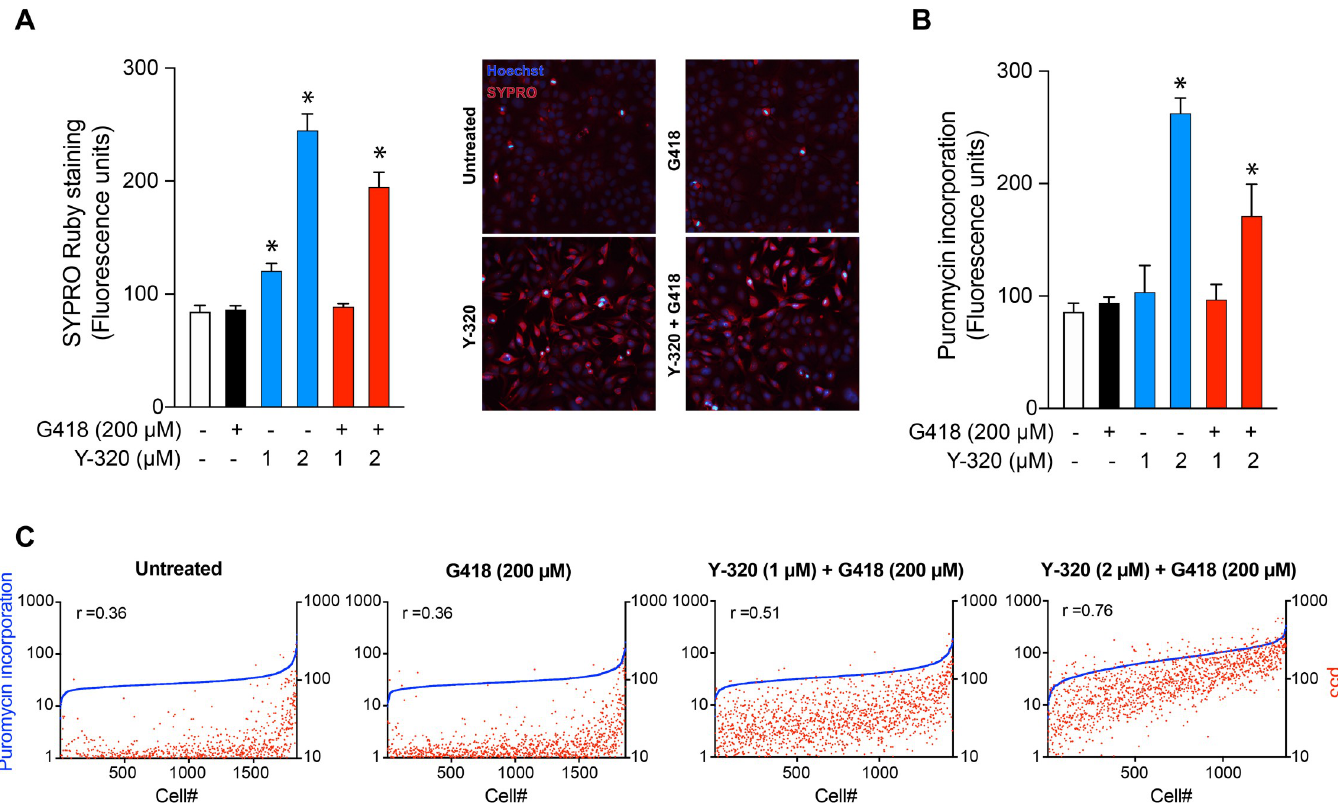
Fig 3. Stimulation of protein synthesis by Y-320 and correlation with p53 readthrough at the single cell level. (A) SYPRO Ruby protein staining. HDQ-P1 cells treated with the indicated compounds for 48 h were stained using SYPRO Ruby. Data were collected by automated fluorescence microscopy. Representative images are shown with SYPRO Ruby stain in red and nuclei in blue. (B) Puromycin detection of protein synthesis. Treated HDQ-P1 cells were exposed to puromycin and labeled with anti-puromycin AF488 antibody. Data were collected by automated fluorescence microscopy. In panels A and B, asterisks show statistically significant differences between treated and untreated cells ( p -value < 0.05; mean ± SD; n = 4). (C) Quantitation of puromycin and p53 in single cells. HDQ-P1 cells treated with the indicated compounds were exposed to 2 μ g/ml harringtonine and 10 μ g/ml puromycin for 10 min. Cells were labeled with anti-puromycin AF488 and anti-p53 AF594 antibodies. The graphs are representative of each condition ( n = 4). Red dots (right y axis) represent nuclear p53 expression and blue dots (left y axis) show cellular puromycin labeling. The Spearman rank correlation coefficient (r) for each condition is shown in each graph. The numerical data underlying the plots can be found in S1 Data.